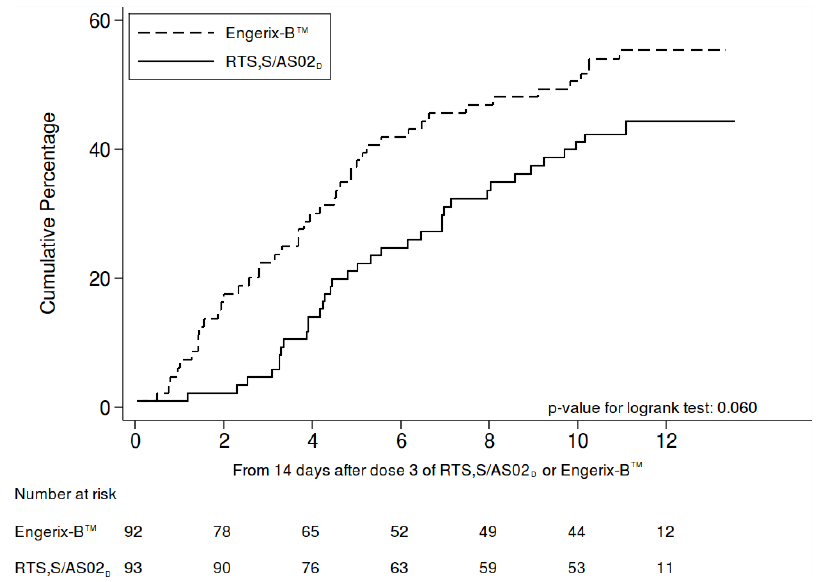
88.2, p=0.003) for the two follow-up periods (ATP 3–9 and ATP 3–14 ), respectively. Discussion This is the first comprehensive safety and reactogenicity report of RTS,S/AS malaria vaccine in infants. We previously reported that VE against new P. falciparum infections was 65.9% during the